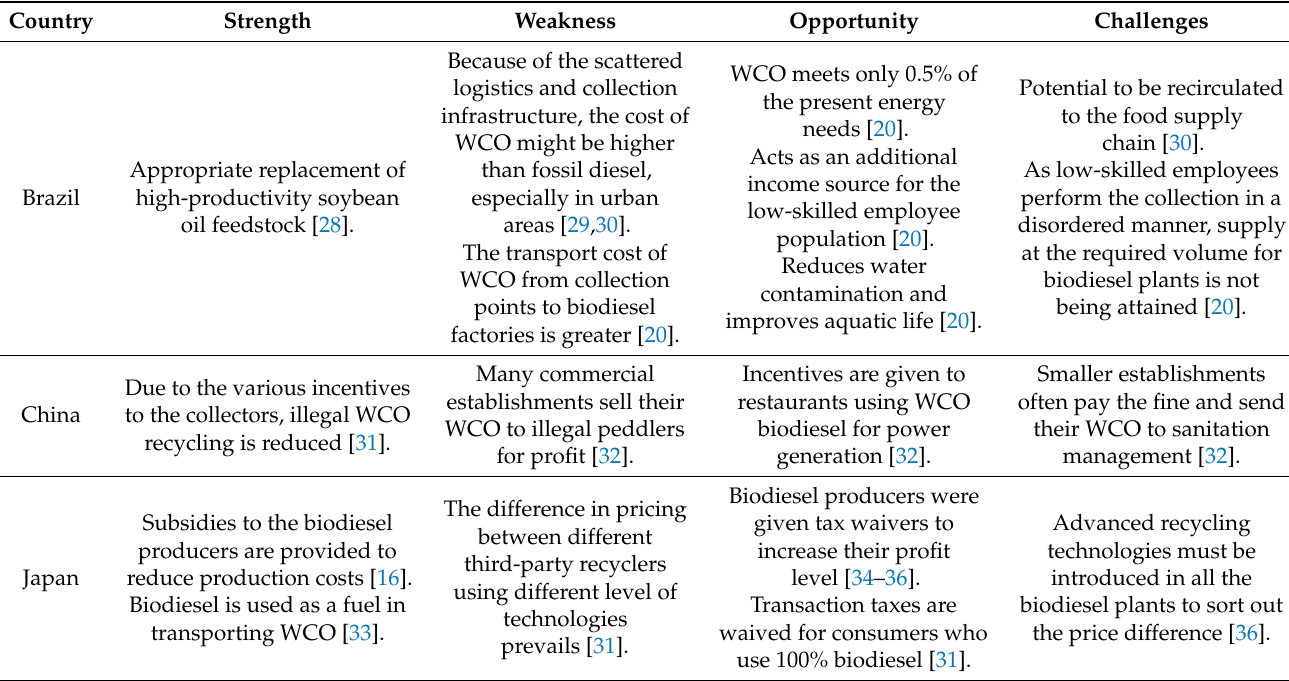
Table 1. SWOC analysis of different countries’ WCO collection